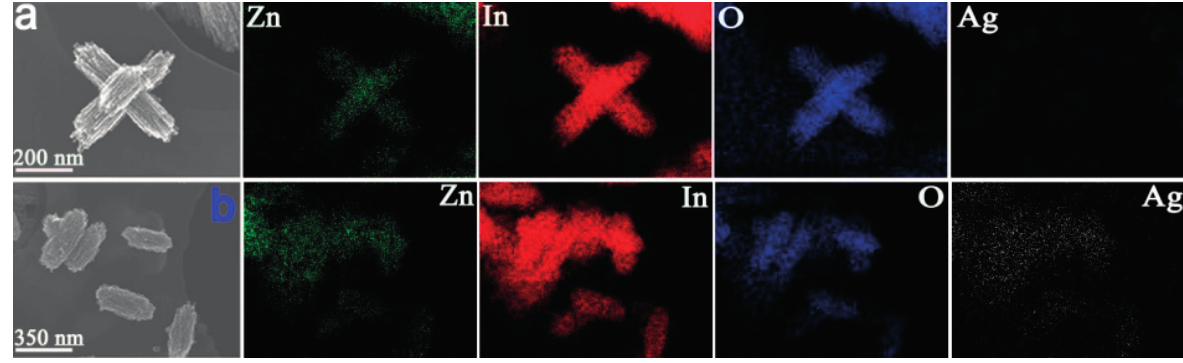
Figure 2. EDX mapping of the Zn, In, O and Ag elements in Z 1 and Z 2: ( a ) Z 1; ( b ) Z